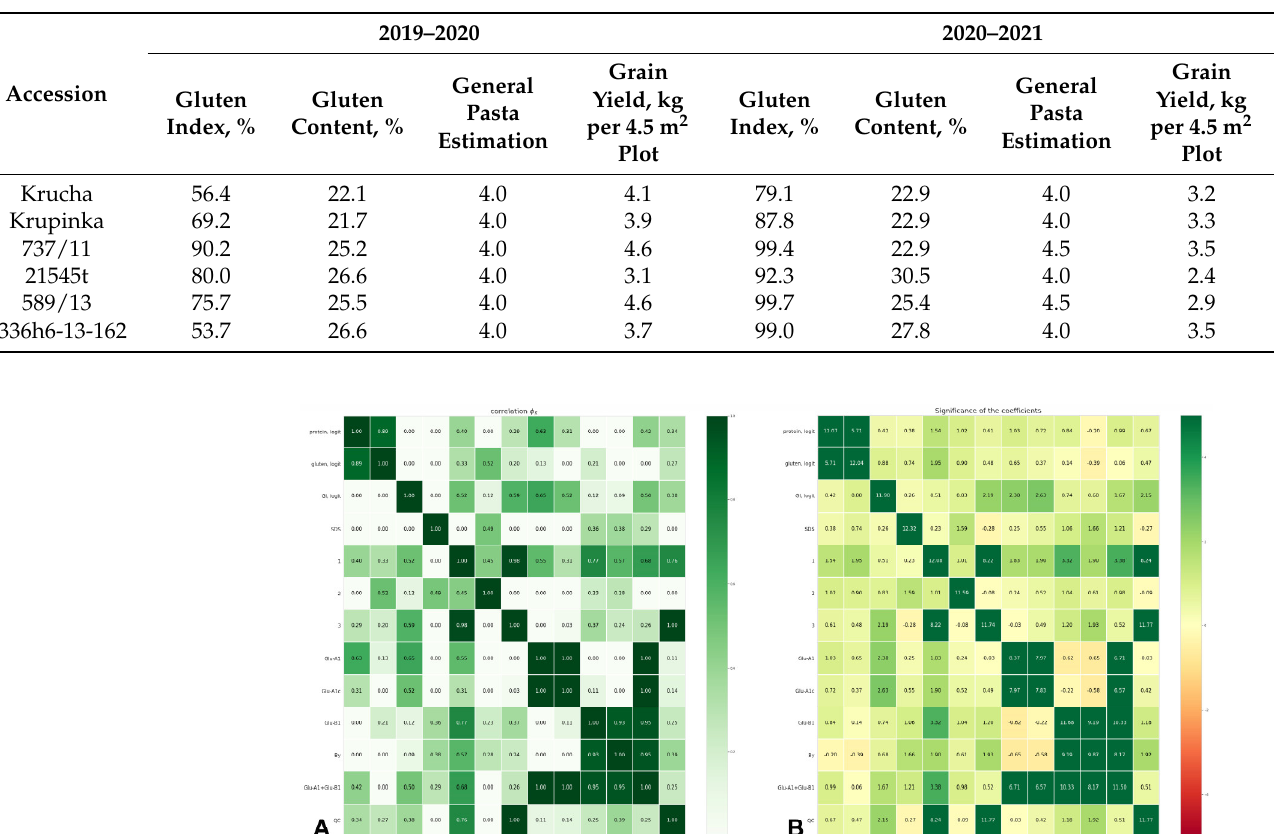
Table 3. The accessions with the superior quality parameters compared with the standards, Krucha and Krupinka, as revealed by two-year field trials.